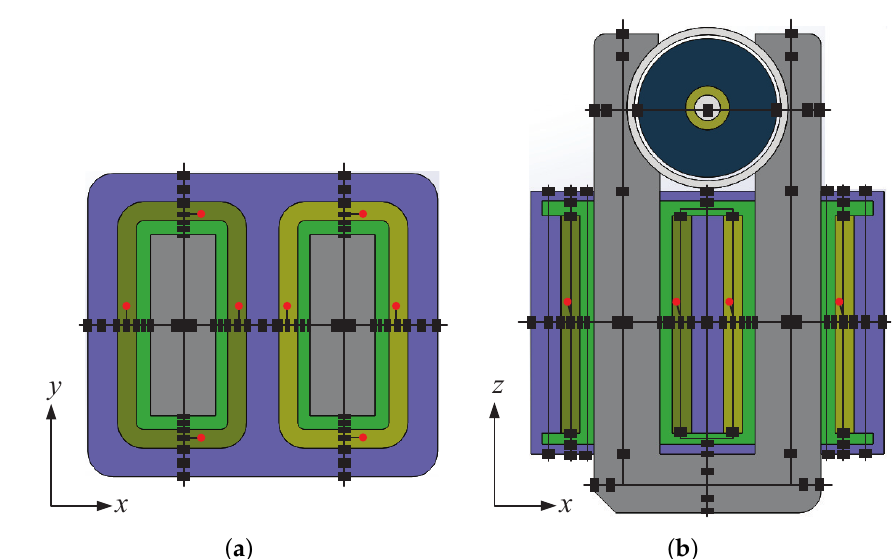
Figure 9. ( a ) Cross section of the electric motor in XY plane. ( b ) Cross section of the electric motor in XZ plane.